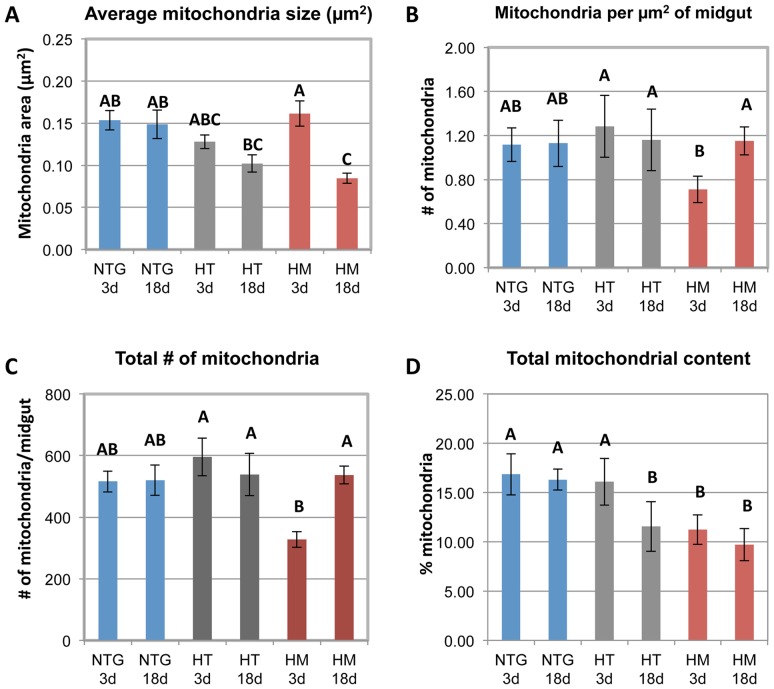
Over-expression of myrAKT was associated with changes in midgut mitochondria number and size.The number and size of mitochondria in the posterior midgut of myrAkt TG and NTG mosquitoes were determined for young (3 d) and old (18 d) mosquitoes within 85.90 µm of the brush border. (A) Average mitochondrial size was significantly decreased in midguts of 18 d old HM females compared to 18 d NTG and to 3 d HM. (B, C) The total number of mitochondria and mitochondrial density was significantly lower in 3 d HM mosquitoes relative to 3 d HT. In addition, the number and density of mitochondria significantly increased as the HM mosquitoes aged. (D) Total mitochondria content (percent area occupied by mitochondria) was significantly decreased in 18 d HT and HM mosquitoes and in 3 d HM mosquitoes relative to NTG controls and 3 d HT mosquitoes. Measurements from 5 midguts for each 3 d genotype and 4 midguts for each 18 d genotype were analyzed using a two-way ANOVA followed by Tukey-Kramer HSD test. Different letters indicate significant differences (alpha = 0.05).